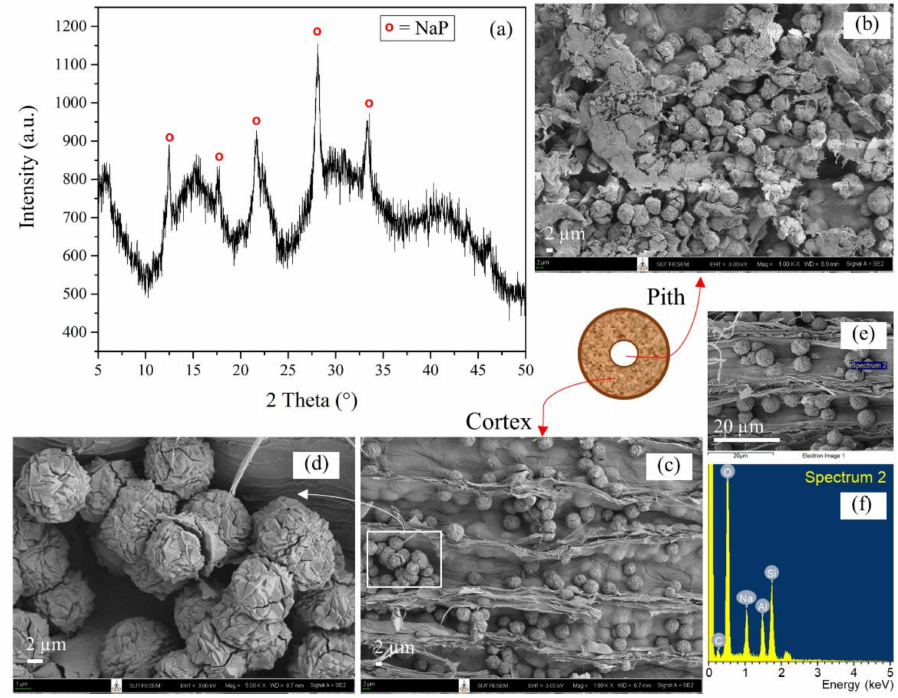
Figure 3. ( a ) XRD patterns, SEM images of Lead tree wood-zeolite composites of untreated wood (NR) ( b ) at pith, ( c , d ) at cortex, and ( e , f ) EDS points analysis